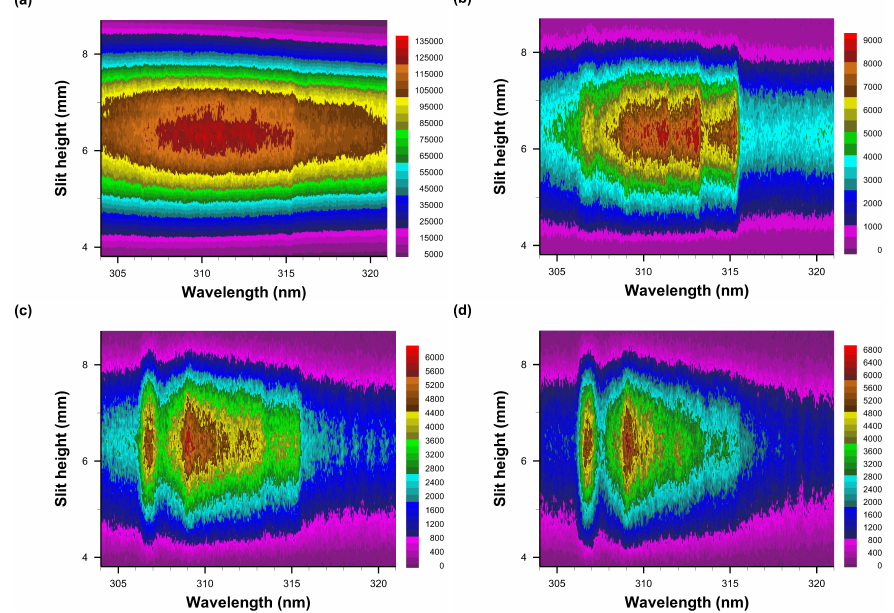
Figure 8. Recorded data of slit-height vs. wavelength. Gate width: 10 µ s, time delay ( a ) 10 µ s—primarily N 2 second positive spectra, ( b ) 20 µ s, ( c ) 30 µ s, and ( d ) 40 µ s. The A-X 0-0 band edge is identified in figure ( b ). Each pseudo-colored image is scaled from minimum to maximum with intensity values as indicated next to the color